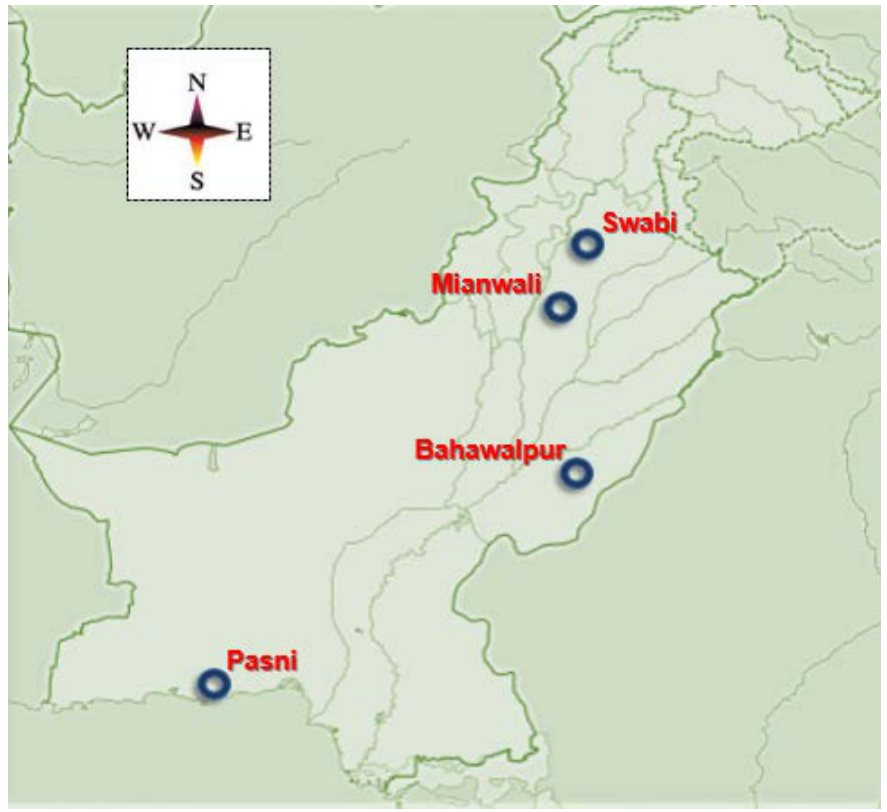
Figure 1: Map exhibiting the soil locations for transformative studies on chemical BSM.